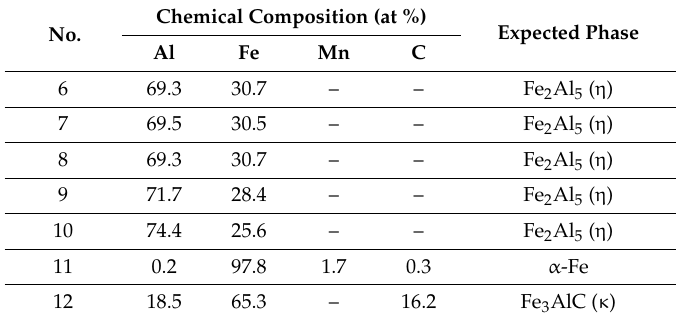
Table 4. EDS results of the phases, denoted as 6–8 in Figure 5e and 9–12 in Figure 7a.